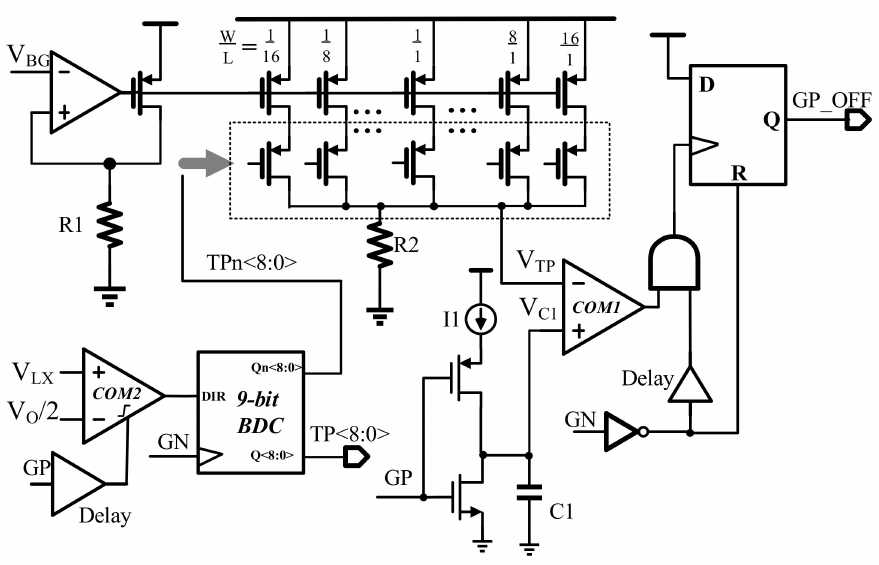
Figure 8. Predictive zero current